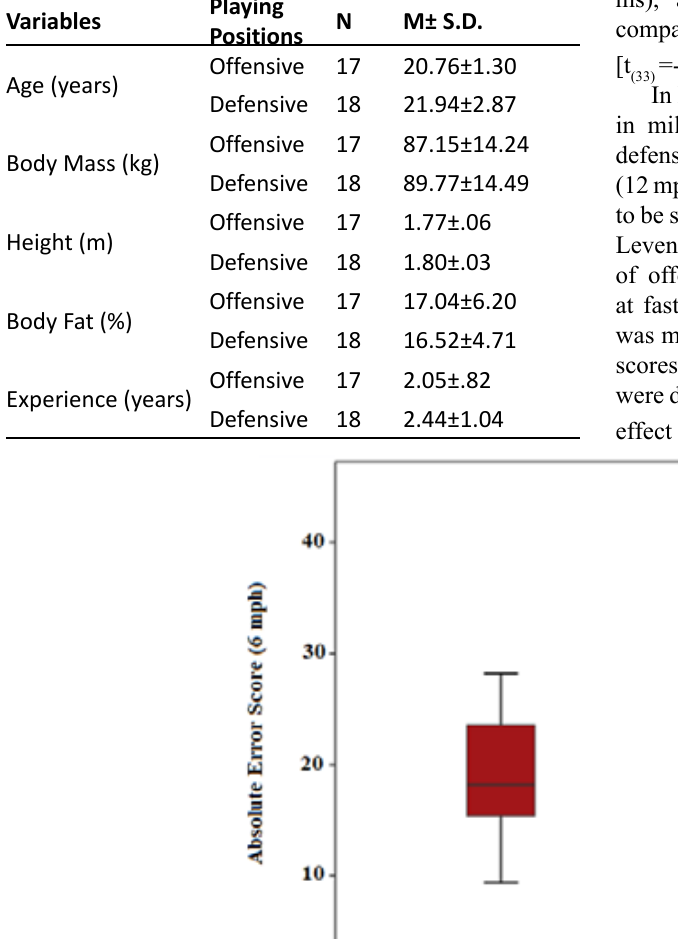
Table 2. The age, height, body weight, body fat percentage and experience values of players